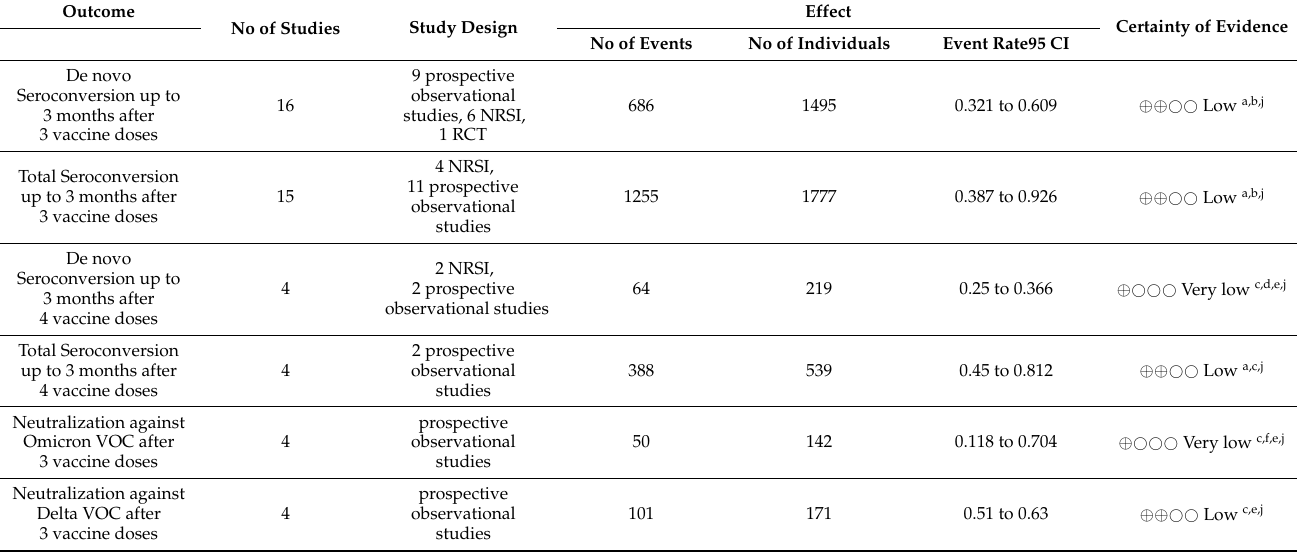
Figure 1. PRISMA flowchart: selection process for articles included in the systematic review. Table 1. Summary of